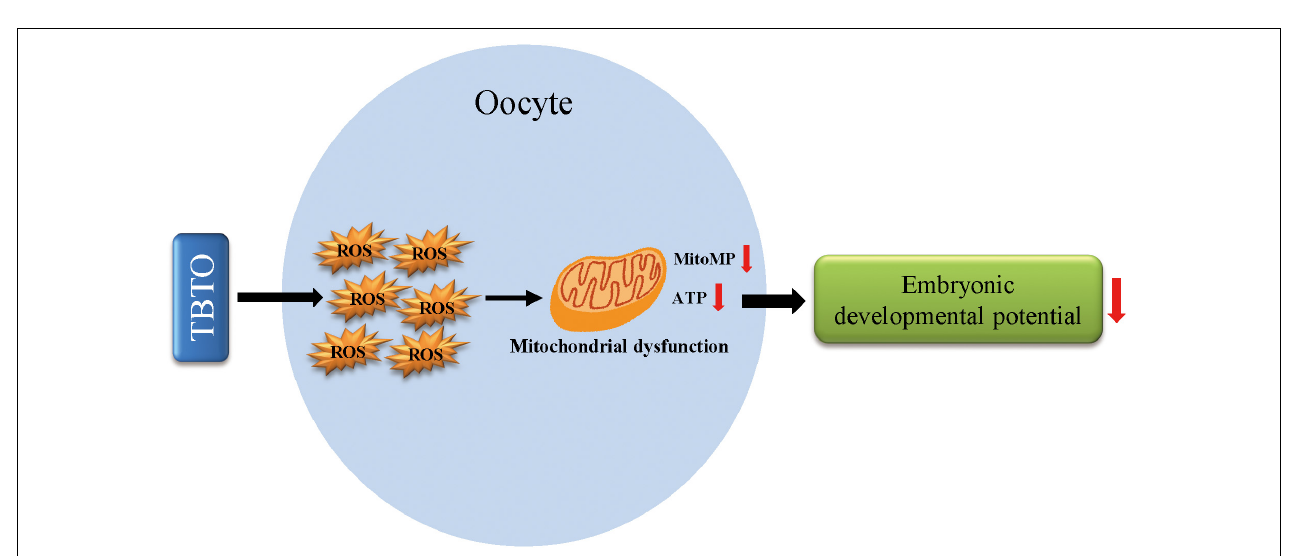
FIGURE 7 | Diagram of the negative effects of TBTO exposure on porcine oocyte maturation. TBTO exposure causes excessive ROS production and induces mitochondrial dysfunction and iron homeostasis disruption, thus impairing oocyte quality and subsequent embryonic developmental